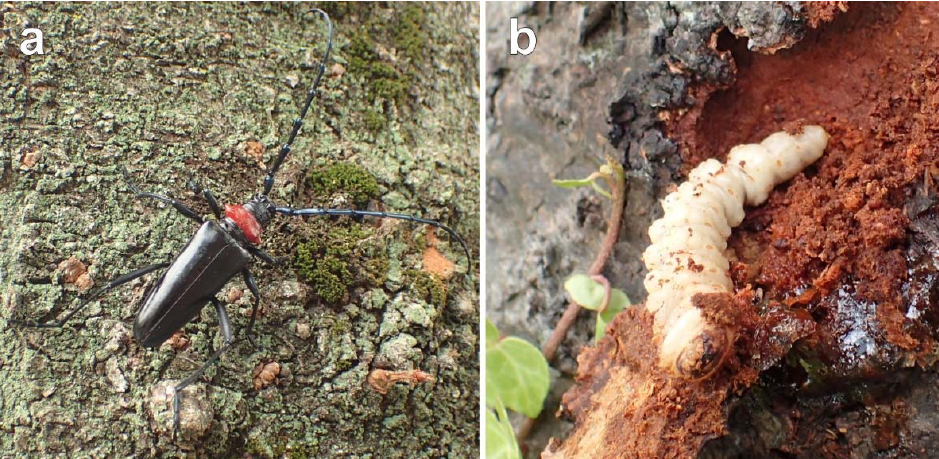
Figure 2. Photos of collected individuals of Aromia bungii in the field. ( a ) An adult female collected on the bark of a cherry tree in Tatebayashi City, Gunma Prefecture, on 28 June 2018. ( b ) A larva collected by peeling bark on a cherry tree in Fussa City, Tokyo Metropolis, on 22 May 2019.